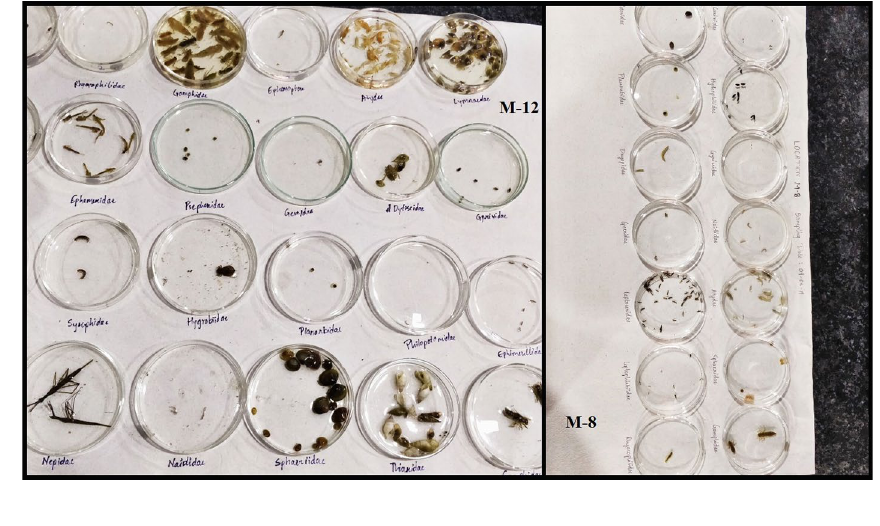
isms sampled at location a M-12 and b M-8, up to family